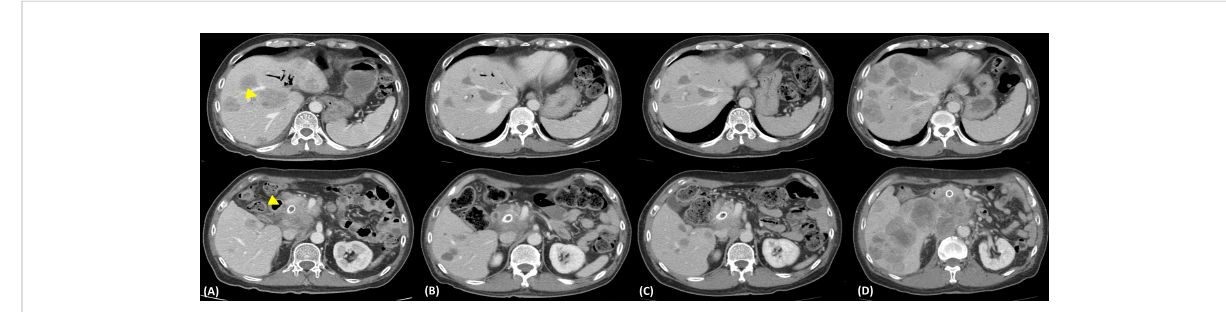
FIGURE 1 Representative axial computed tomography images. (A) Image depicting the disease status before liquid biopsy, with an ill-de fi ned heterogeneous mass about 5.4 cm at the pancreatic head (dotted arrows) and multiple liver metastases 9arrow) (B) Subsequent imaging following 3 months of entrectinib treatment (600 mg/day) illustration the resolution of the pancreatic tumor (sized 4.2 cm) and liver metastases (C) After 6 months of entrectinib with a further resolution of the tumors. The pancreatic tumor sized only 3.8 cm (D) Disease progression (pancreatic tumor sized 7.4 cm) and increased number of liver